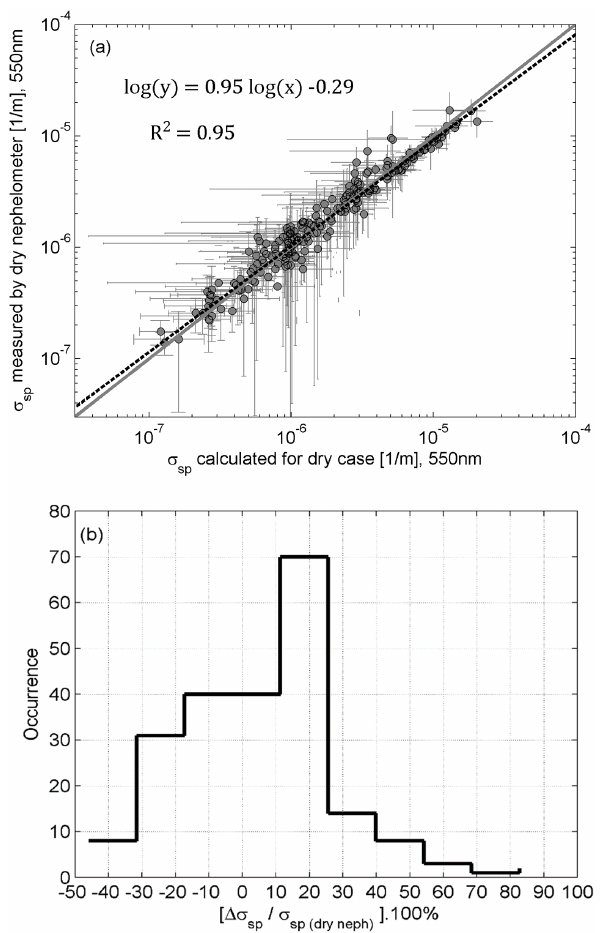
Figure 5. (a) Correlation between modeled and measured daily mean dry σ sp (550nm) for the year 2008. The error bars indicate the standard deviations of the daily averages. (b) Histogram of the deviation of the modeled scattering coefficient from measurements in percentage (%).